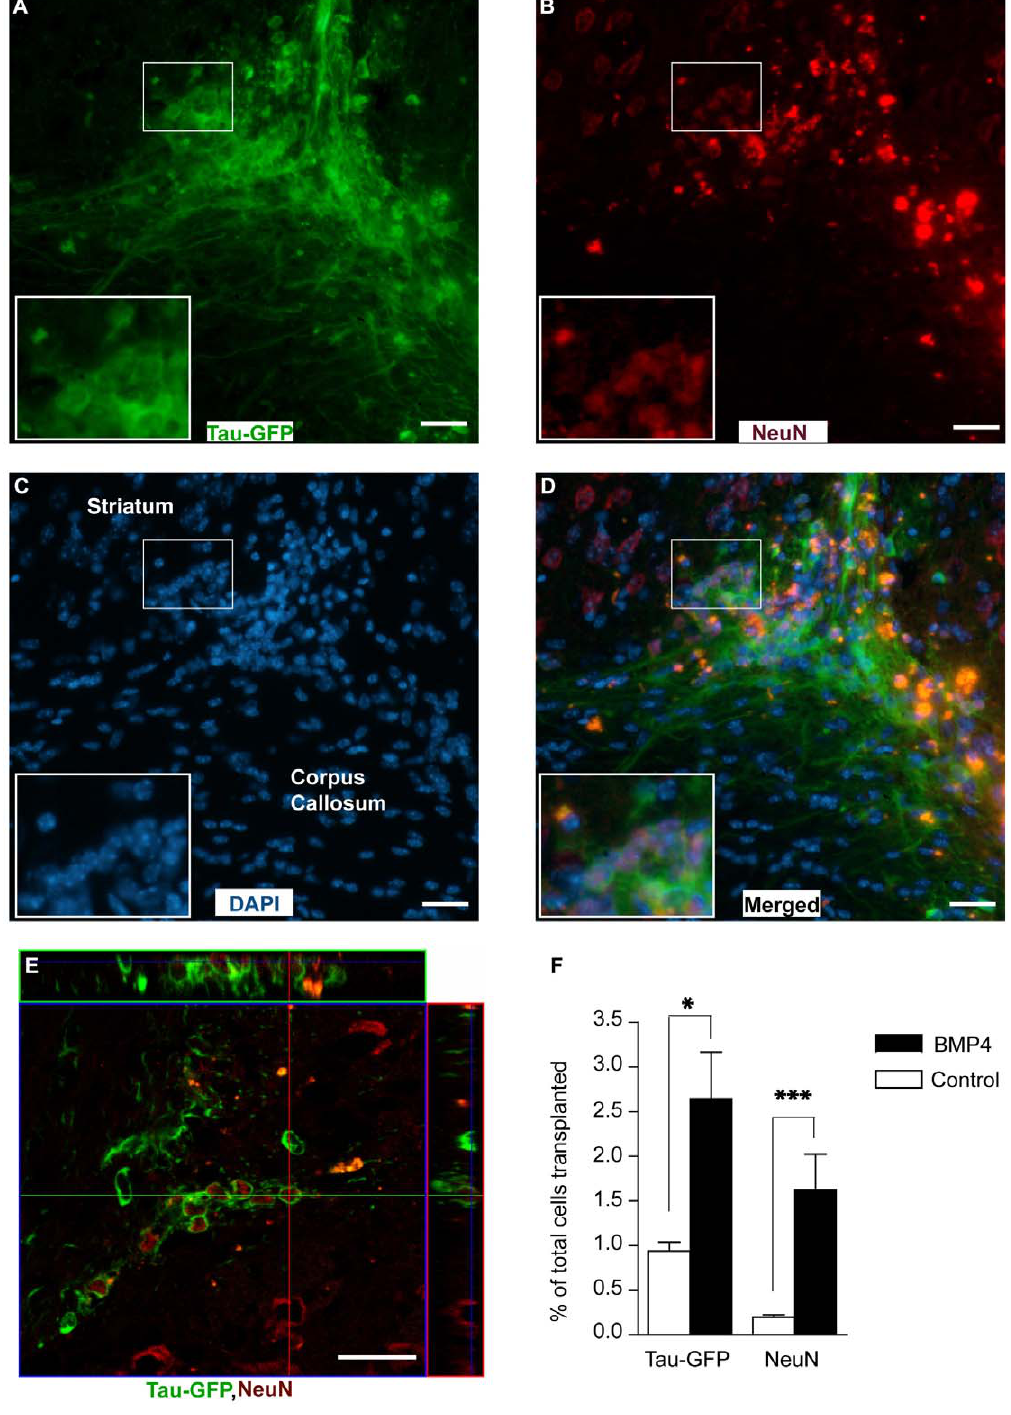
Figure 5. BMP-4 treatment of sorted P1 population improves their survival in adult mouse striatum. Freshly sorted cells P1 cells were resuspended in medium supplemented with 40 ng/ml of BMP-4 at a density of 5 6 10 4 cells/ m l (2 m l /animal) and injected into the right striatum of intact C57-BL6 mice and their survival was analysed 4 weeks later. ( A–D ): Representative micrographs from BMP4 group show that some of the implanted immature neurons survived and expressed the mature neuronal marker; NeuN. ( E ): Confocal micrograph from the same group shows some GFP-NeuN immunoreactive cells. ( F ): Bar graph shows the percentage of survived Tau-GFP and NeuN-IR cells in control and BMP4 groups as of total cells (1 6 10 5 cells/animal) transplanted (mean 6 SEM; n=4 animals/group, * P , 0.05, ***P=0.0002, Student’s t-test). Scale bars=20 m m. Abbreviation: NeuN=Neuronal nuclei.